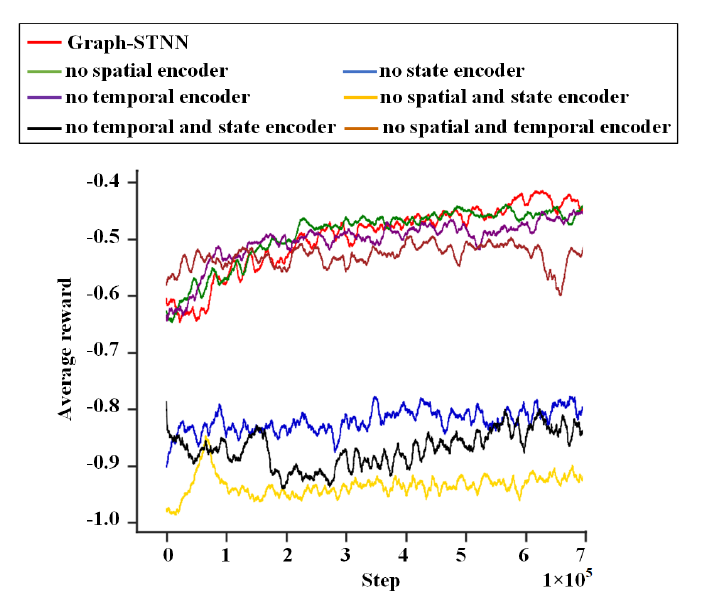
Figure 12. The training performance of Graph-STNN and the removal of some of its components on randomly generated simulation environments, with the size of 20 m × 20 m. Next, we test the trained network with the map size of 20 m × 20 m, 30 m × 30